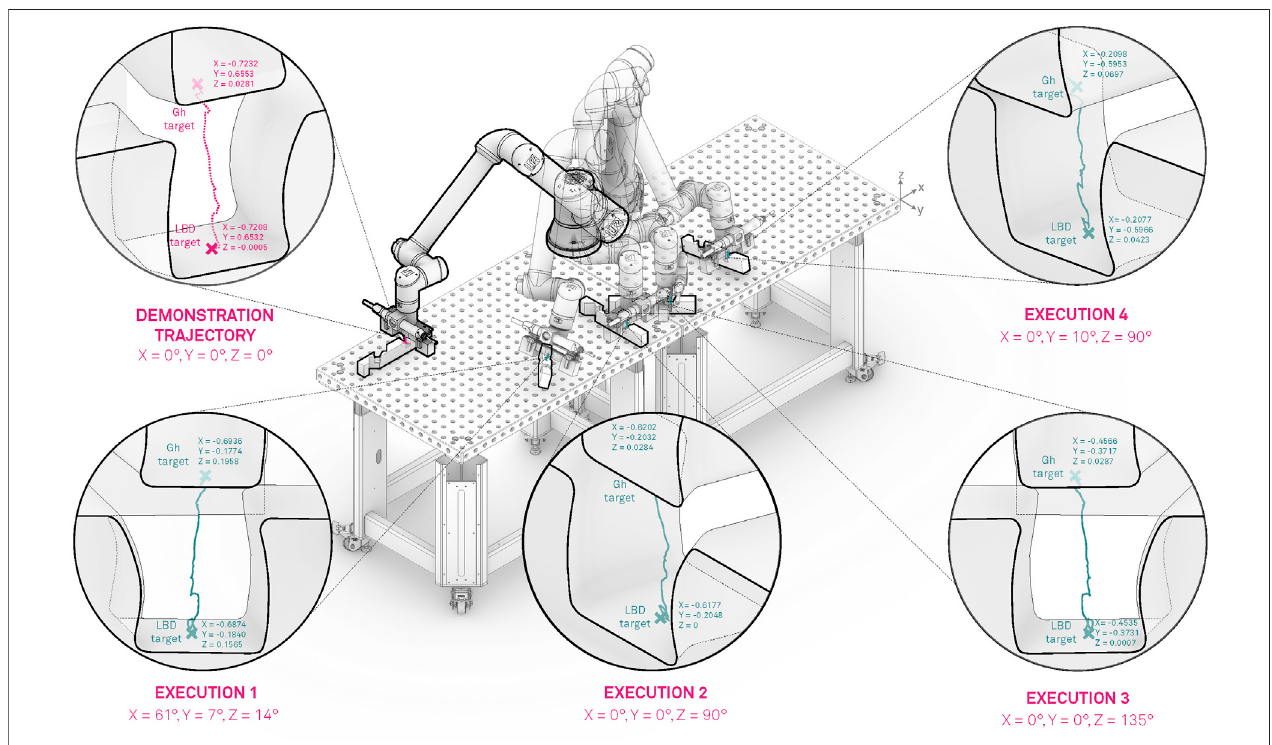
FIGURE 7 | Modulation and execution of the demonstrated motion in various locations of the robot workspace.